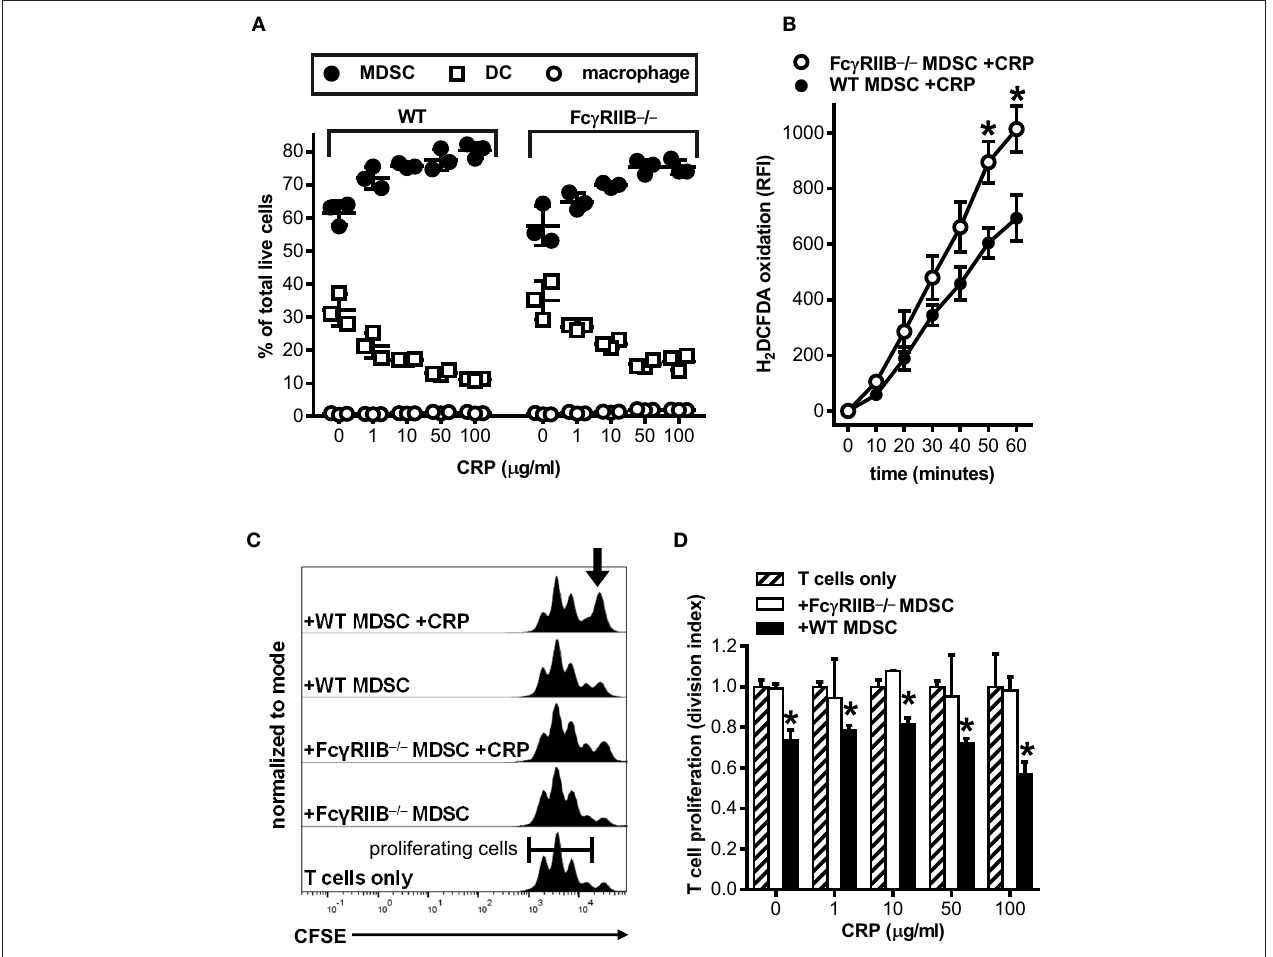
FIGURE 4 | Human CRP does not enhance the suppressive capacity of mouse Fc γ RIIB − / − MDSCs. Mouse MDSCs were generated from bone marrows supplied by wild type (WT) versus Fc γ RIIB − / − mice to study the receptor’s requirement for the generation of MDSCs and to assess its requirement for CRP dependent production of iROS and suppression of T cell proliferation. (A) The absence of Fc γ RIIB expression has no impact on human CRP’s ability to drive MDSC generation. The data shown (mean ± SD) are representative of n = 4 separate cultures each conducted in triplicate (compare to Figure 1G ). (B) The absence of Fc γ RIIB expression increases CRP triggered (100 µ g/ml) iROS generation by enriched MDSCs. The data shown (mean ± SEM) are pooled across three separate cultures each conducted in triplicate. The asterisks indicate p < 0.05 for unpaired t -tests compared to time-matched WT. (C) Representative CFSE dilution histograms (normalized to mode) for WT mouse CD4 + T cells stimulated with anti-CD3 and anti-CD28 mAbs; from bottom to top the T cells received no other treatment, enriched Fc γ RIIB − / − MDSCs, enriched Fc γ RIIB − / − MDSCs plus human CRP, enriched WT MDSCs, or enriched WT MDSCs plus human CRP. When MDSCs and CRP were added they were added at 1E:5T and 100 µ g/ml, respectively. Note that addition of CRP only enhanced the suppressive capacity of enriched MDSCs (indicated by the increased proportion of undivided T cells shown by the arrow in the top trace). (D) T cell proliferation (division indices; see the Materials and Methods ) for the representative mean + SD of two co-cultures conducted in triplicate of (C) . The asterisks indicate significantly lower division indices ( p < 0.05 for Dunnett’s tests) at each dose of CRP when using WT MDSCs vs. no